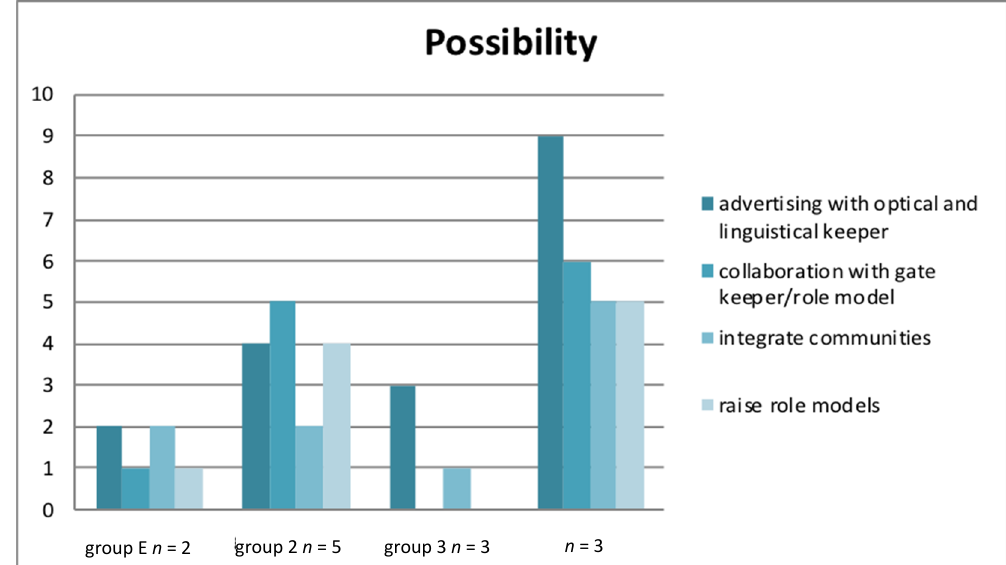
Figure 3. Results on how to overcome the barriers.